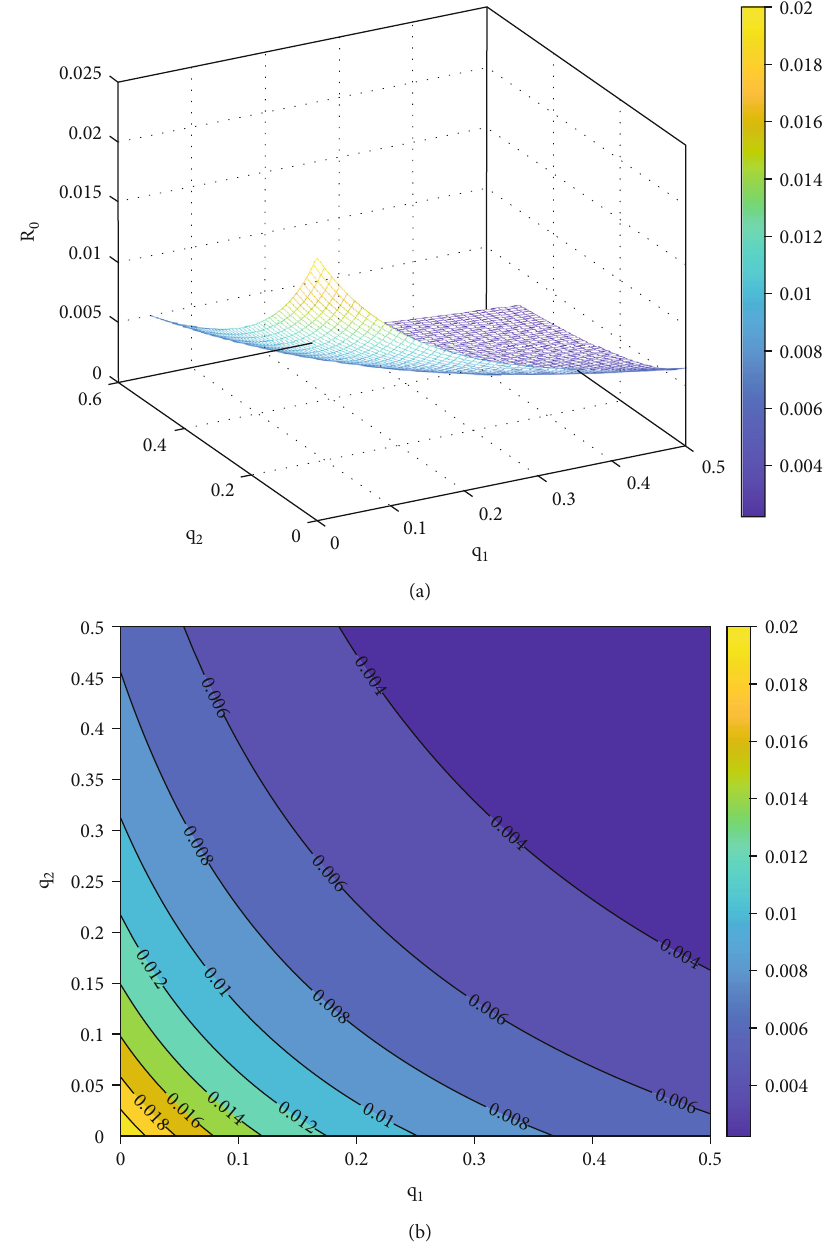
Figure 3: The dynamics of R